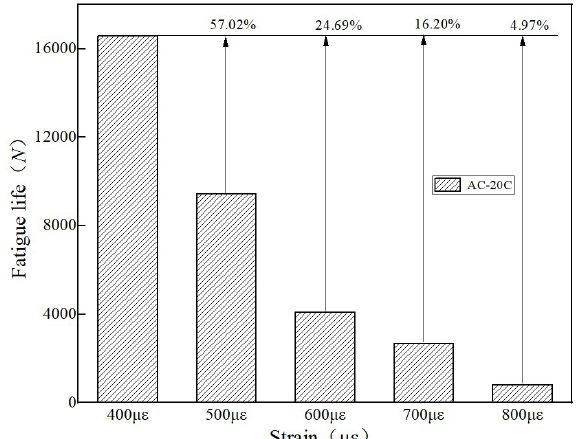
Fig. 1. Relationship between strain and fatigue life